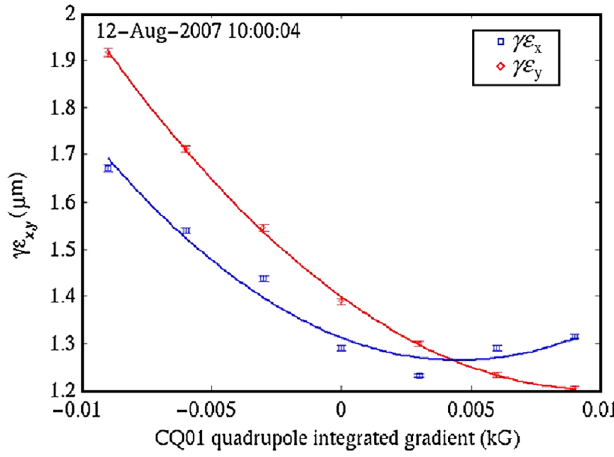
FIG. 10. (Color) Horizontal (blue) and vertical (red) emittance at 135 MeV and 1 nC optimized (parabolic fit) by varying the gun-solenoid’s normal quadrupole coil field, CQ01 .